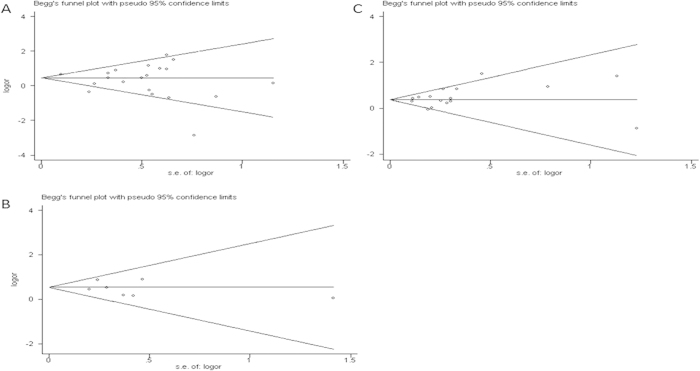
Funnel plot analysis to detect publication bias for each of the 8q24 polymorphism by homozygous model.(A) For rs1447295 polymorphism, (B) For rs16901979 polymorphism, and (C) For rs6983267 polymorphism. Each point represented an individual study for the indicated association.